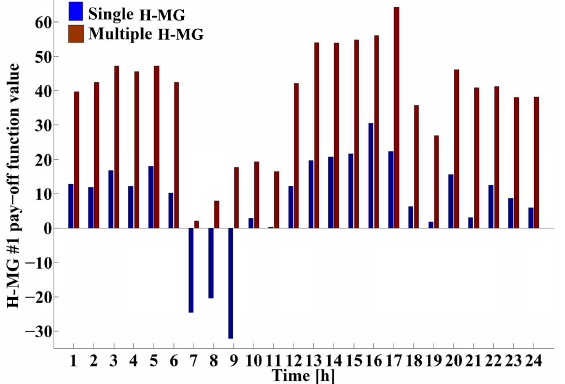
Figure 13. Pay-off function related to H-MG #1 in the single H-MG and MH-MG under Scenario #1.